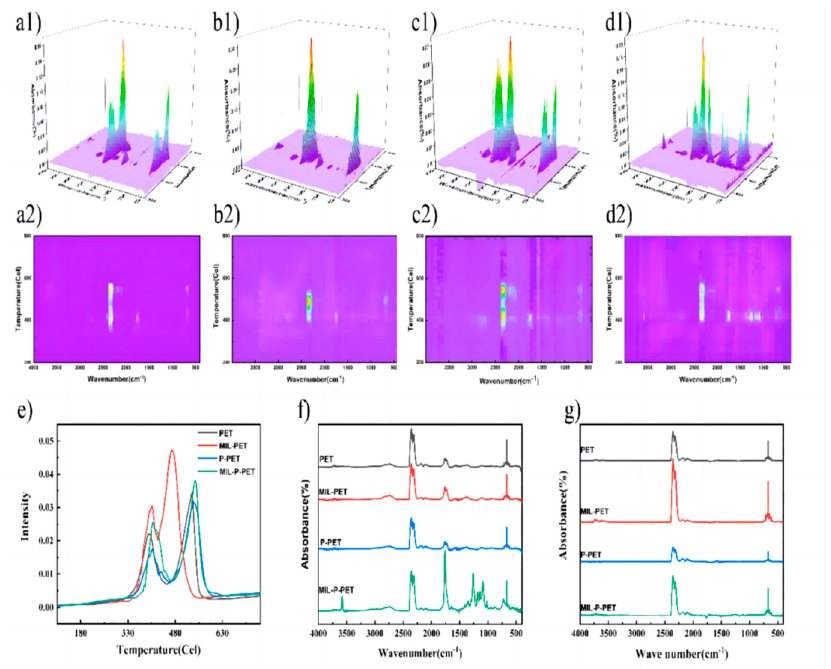
Figure 12. 3D spectra and its vertical view of TG − FTIR in air atmosphere of ( a1 , a2 ) PET, ( b1 , b2 ) MIL − PET, ( c1 , c2 ) P − PET, and ( d1 , d2 ) MIL − -P − PET. The ( e ) Gram − Schmidt curves and ( f , g ) FTIR in ( b1 , b2 ) MIL-PET, ( c1 , c2 ) P-PET, and ( d1 , d2 ) MIL–P-PET. The ( e ) Gram-Schmidt curves the second highest and highest peaks of Gram − Schmidt curves of PET, MIL − PET, P − PET, and MIL − P − PET.